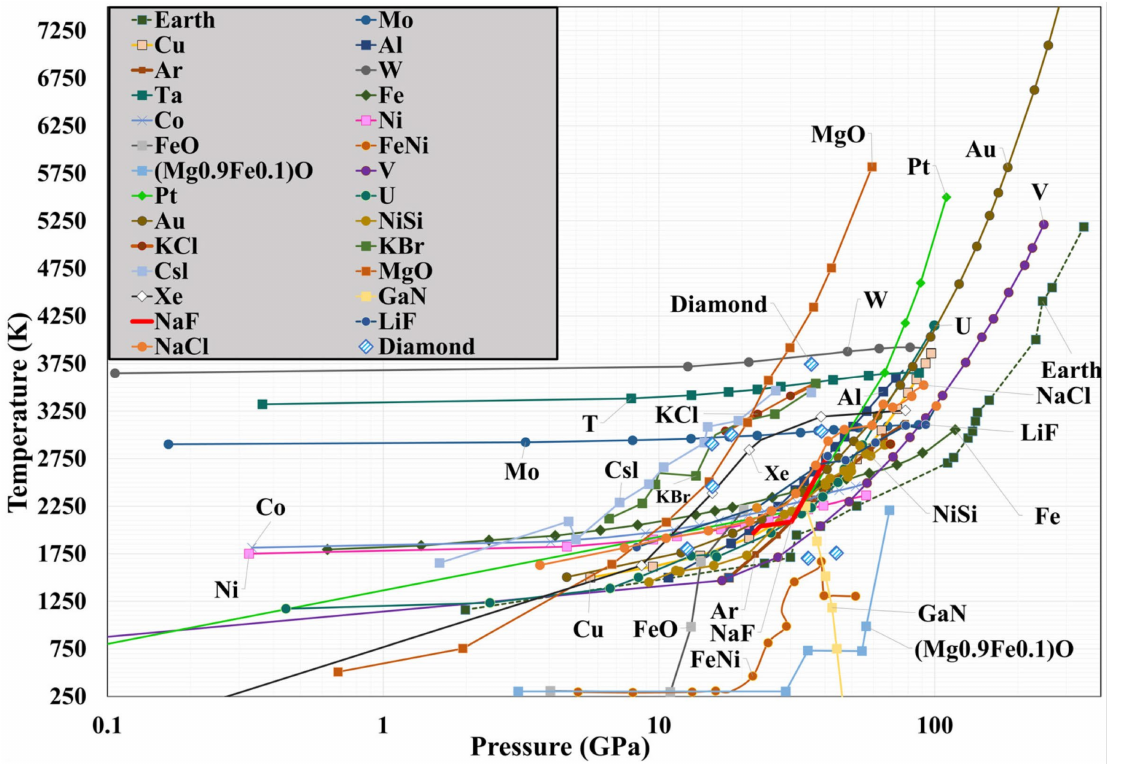
Figure 9. Example of phase transformation studies using LH-DAC systems, chosen from the selected 206 articles, showing melting curves of many elements and various binary/ternary alloys and compounds. Earth’s P-T curve is shown for comparison in the mantle to core regime.